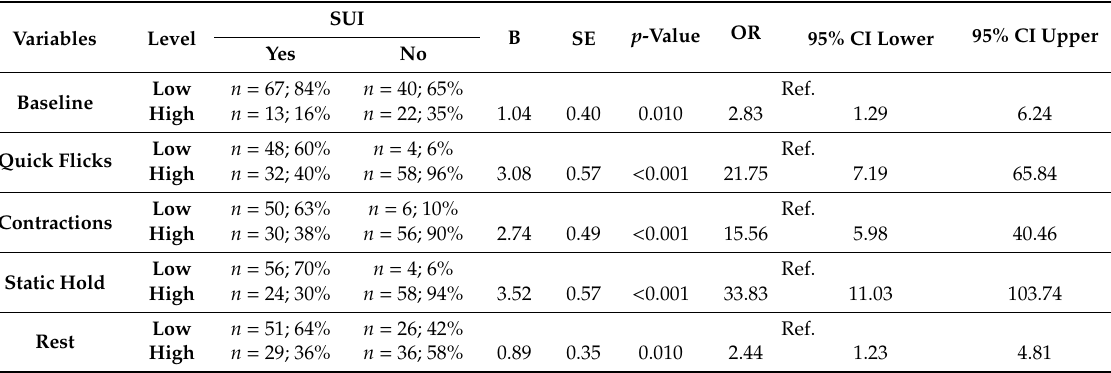
Table 4. Assessment of the impact of sEMG activity (categorized variables) on the absence of SUI (univariate logistic regression